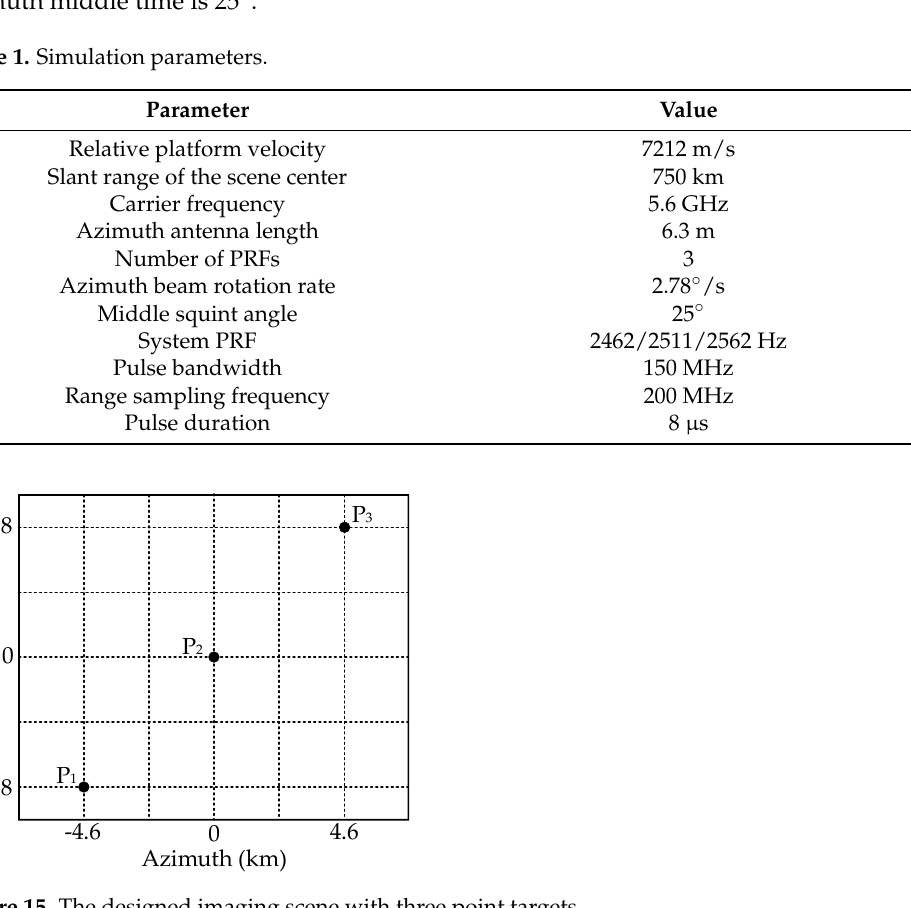
Figure 15. The designed imaging scene with three point targets.